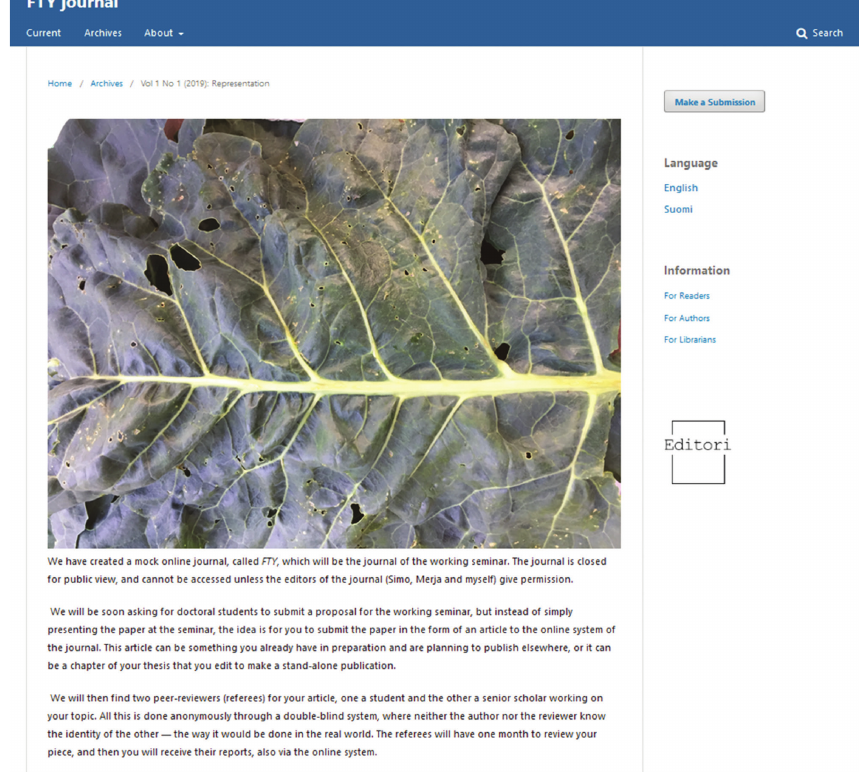
Fig. 1: FTY journal in the Editori